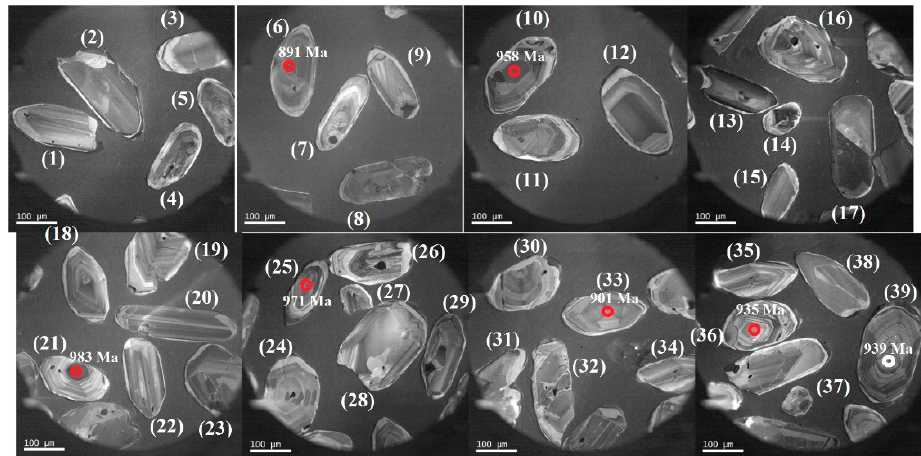
Figure 3. BSE-CL images showing internal texture of zircon crystals with analyzed spots (from Araru black to whitish gneiss).